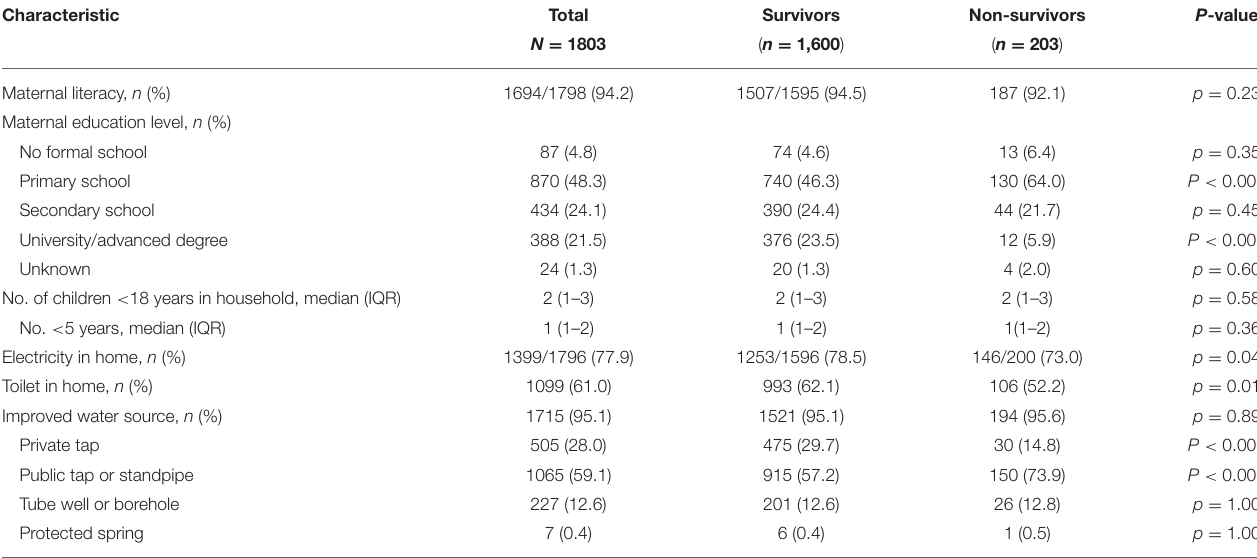
TABLE 2 | Descriptive statistics for the full cohort and a comparison of socioeconomic characteristics by mortality outcome. Characteristic